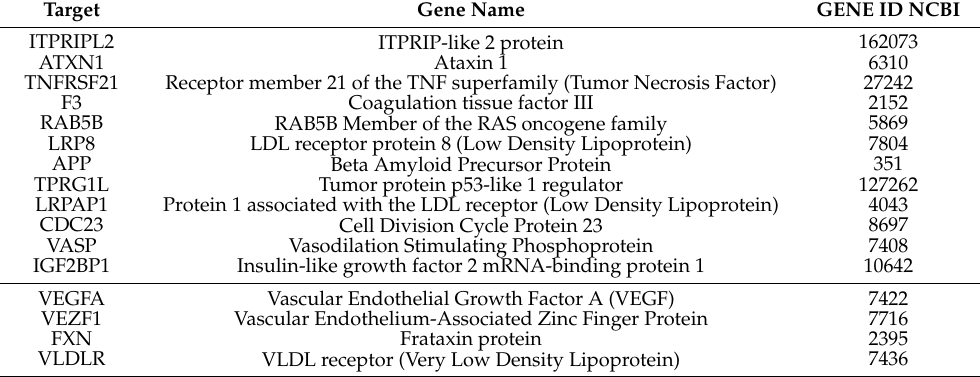
Table 10. Targets of miR 93-5p.